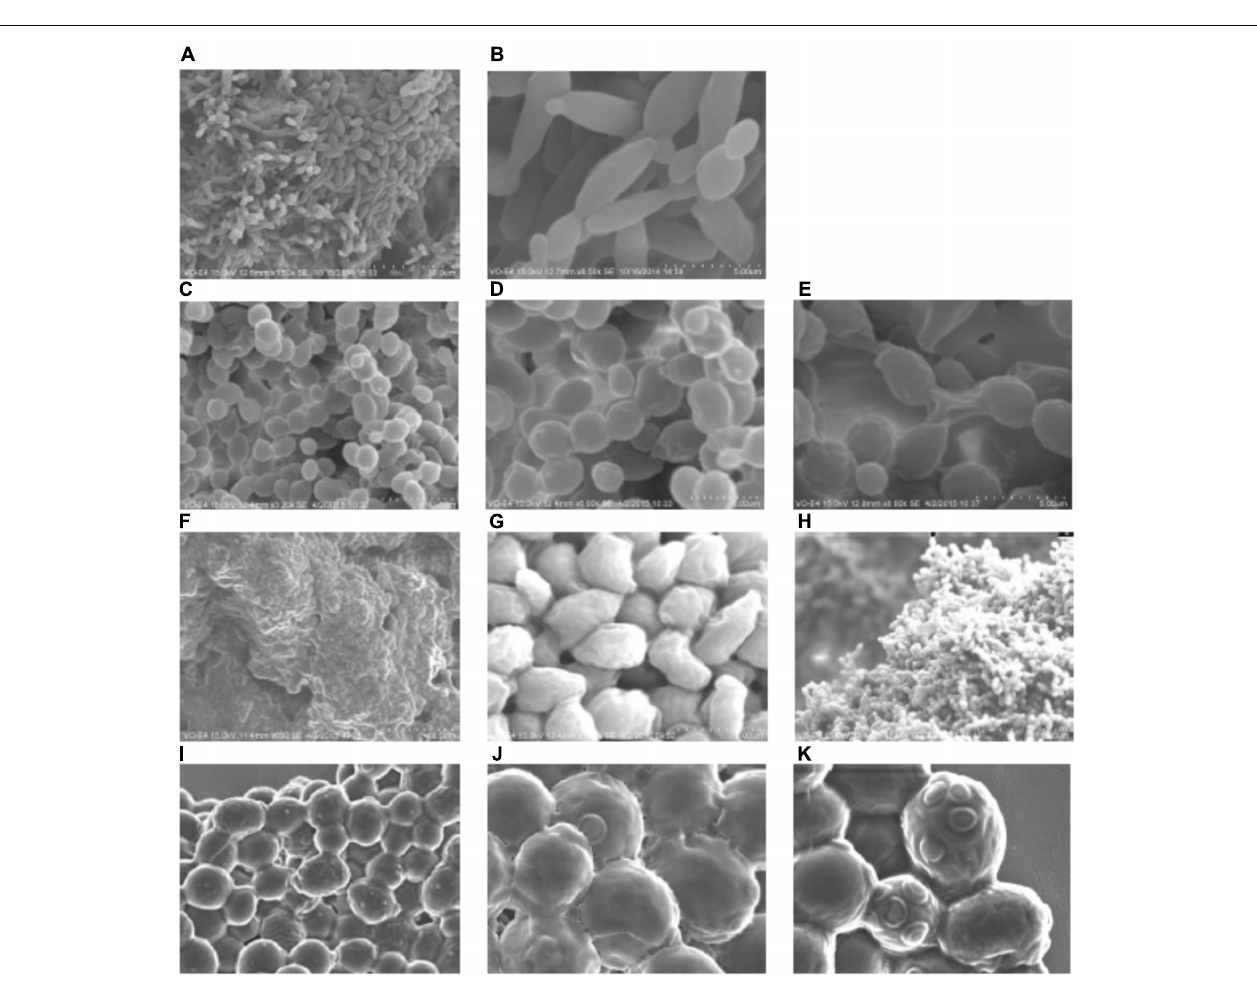
FIGURE 2 | Scanning electron microscopy of velum: (A) × 2,000 (B) × 8,500 ovoid yeast and elongated pseudomycelium yeast; (C) × 3,000 (D) × 6,000 (E) × 8,000 yeast biofilm where yeasts are present in short chains of several cells; (F) × 650 (G) × 7,000 (I) × 5,000 (J,K) × 10,000 very dense biofilm with network of yeast, with all yeast cells embedded in an extracellular matrix; (H) × 1,000 velum in 3D like structure is visible formed by a sequence of ovoid cells attached together by their pole in an apparently disorganized manner.